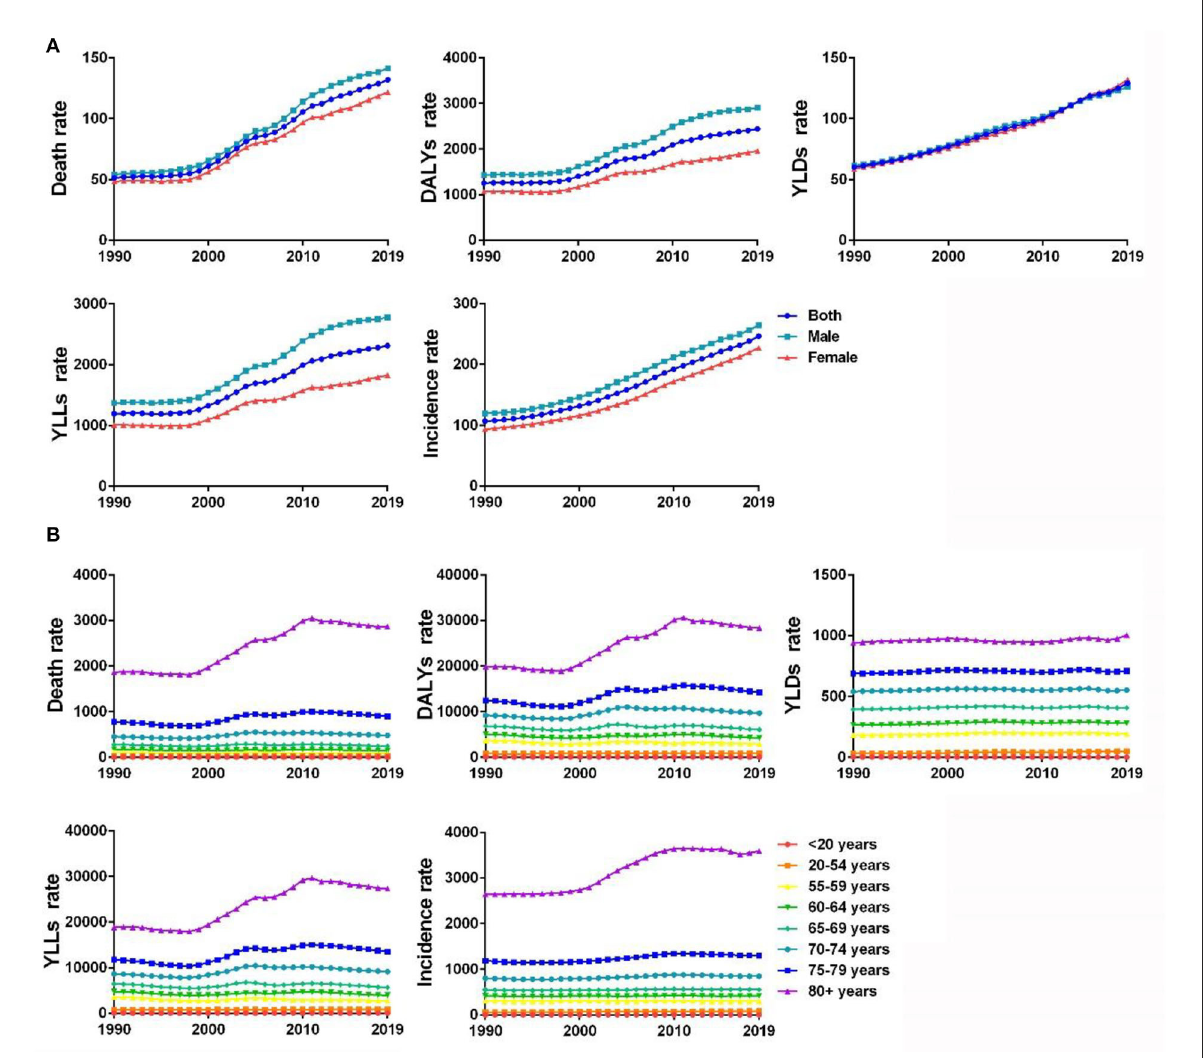
FIGURE1 (A) Gender differences in disease burden of IHD in China from 1990 to 2019 (1/100,000). (B) Disease burden of IHD in different age-groups in China from 1990 to 2019 (1/100,000).